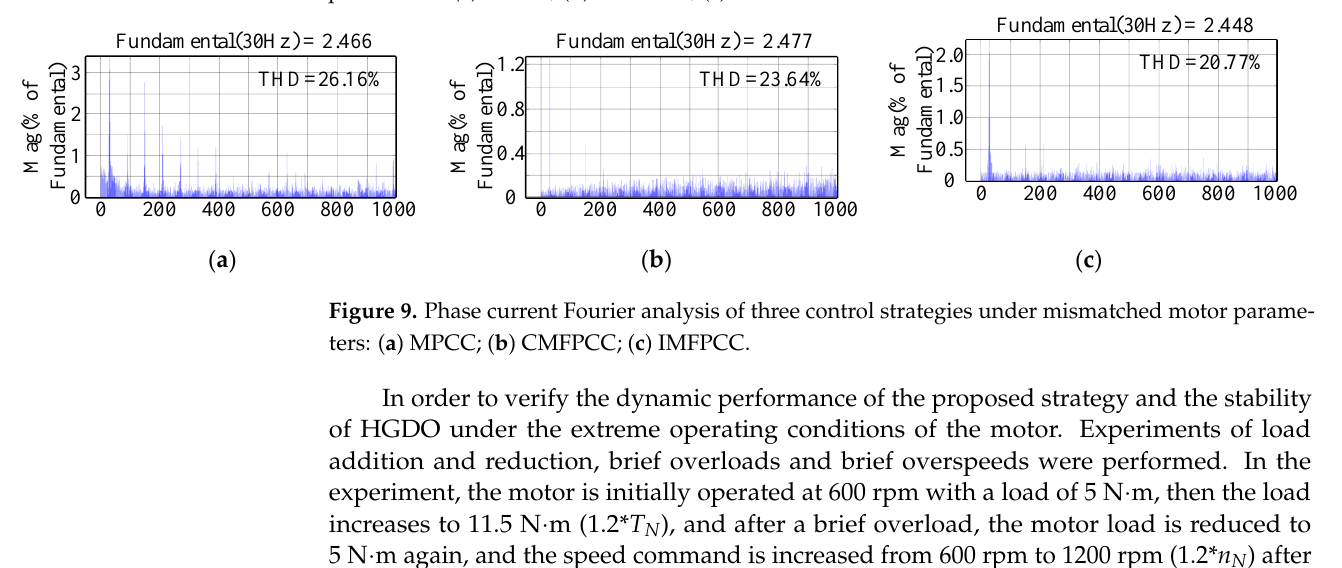
Figure 8. Experimental results of dq − axis current and phase current under mismatched motor parameters: ( a ) MPCC; ( b ) CMFPCC; ( c ) IMFPCC.